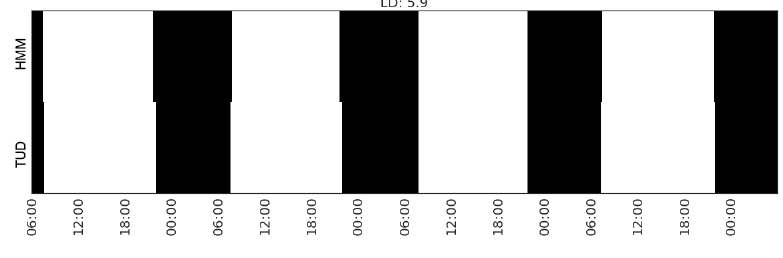
Figure 18. Recognising the activity of sleeping in Household 3 with feature set